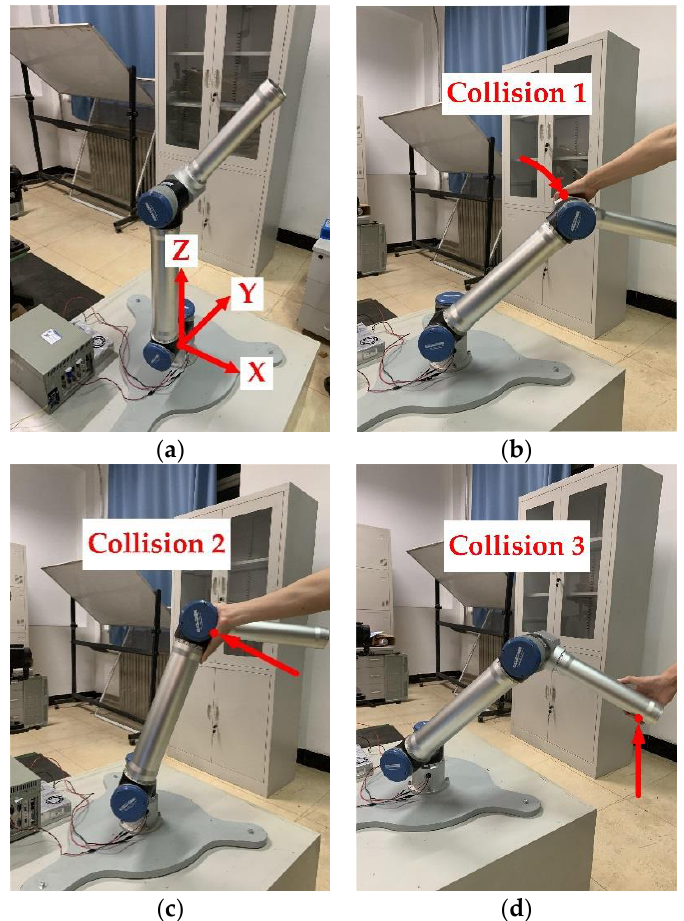
Figure 4. Experimental verification of collision detection performance: ( a ) Initial posture; ( b ) First experiment: Collision 1 in the waist joint; ( c ) Second experiment: Collision 2 in the shoulder joint; ( d ) Third experiment: Collision 3 in the elbow joint.